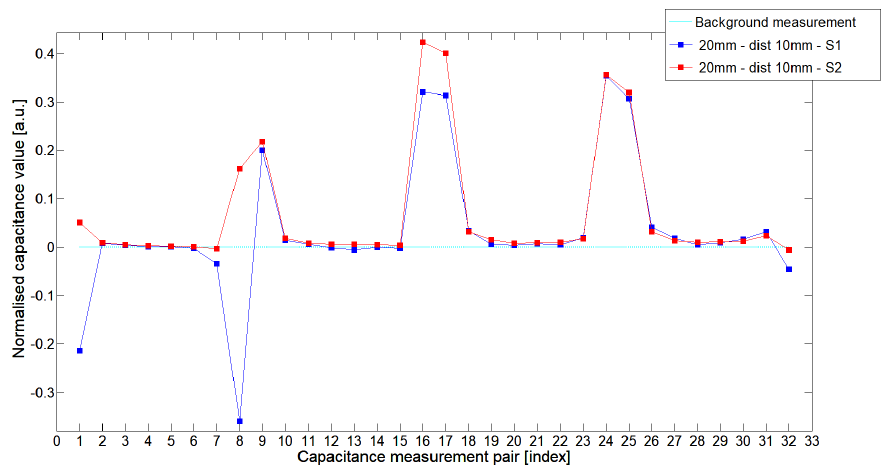
Figure 17. The 1st electrode measurement cycle (S1: 1->32 and S2: 1->32) for Test20 P 3 and S1—blue line, S2—red line. Cyan line indicates lower calibration limit.